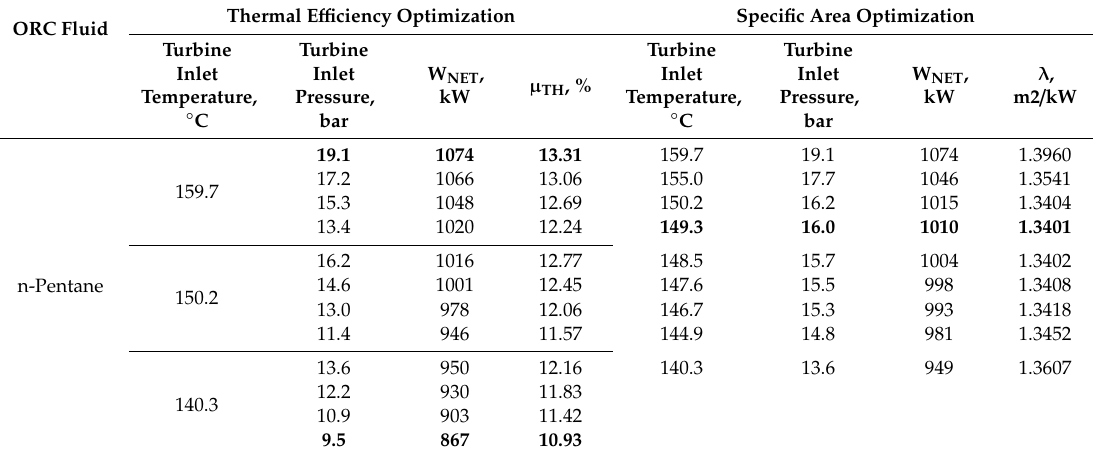
Table 5. Optimization Data Result (bold represent optimized